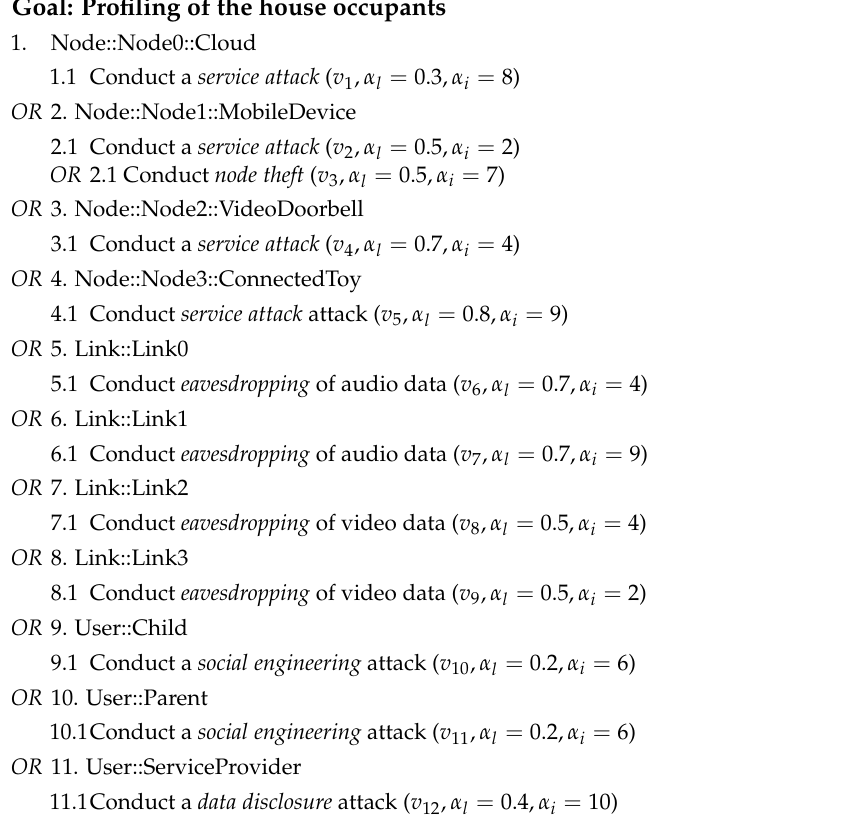
Figure 5. Attack tree with the attacker’s goal being that of profiling the house